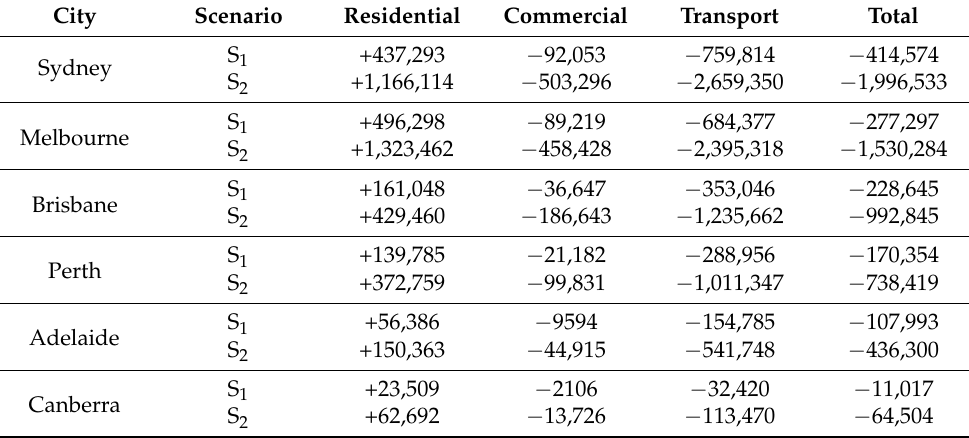
Table 6. Effects of WFH on total GHGE (tCO 2 -e) [positive: increase; negative: